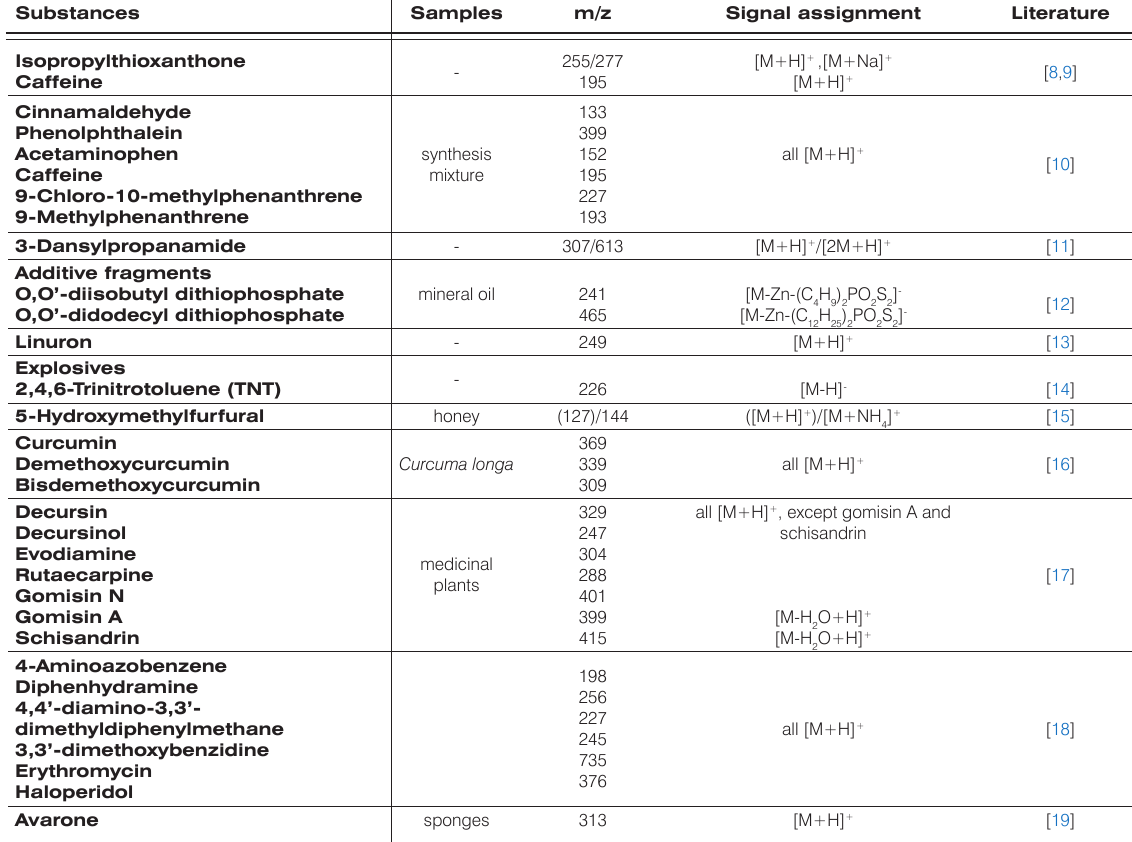
Table 1. TLC/HPTLC-DART-MS signals of substances